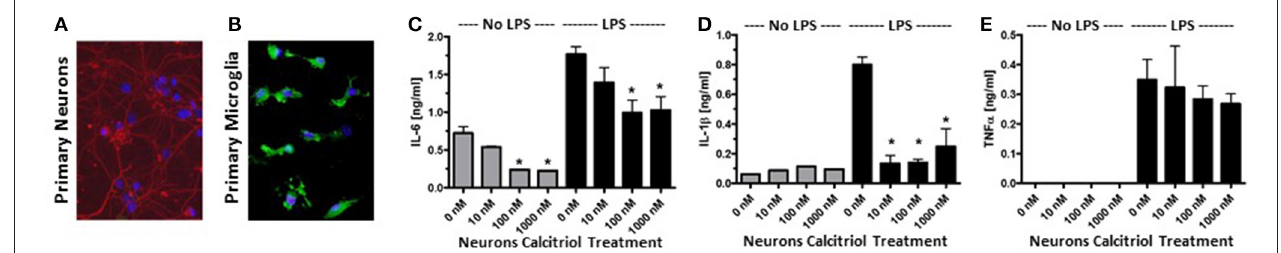
FIGURE 2 | Vitamin D signaling in primary neurons reduces pro-inflammatory cytokine production by microglia. (A) Primary neurons were isolated from the hippocampus of post-natal day 1 mice. Red— β -tubulin; Blue—DAPI. (B) Primary microglia stained with Iba1 (green) and DAPI (blue). The primary neurons were cultured with calcitriol and the media was collected and transferred to the primary microglia. After 24h, the microglia were washed, activated with LPS, supernatants collected, and IL-6 (C) , IL-1 β (D) , and TNF α (E) were measured in the supernatants by ELISA. * p < 0.05.